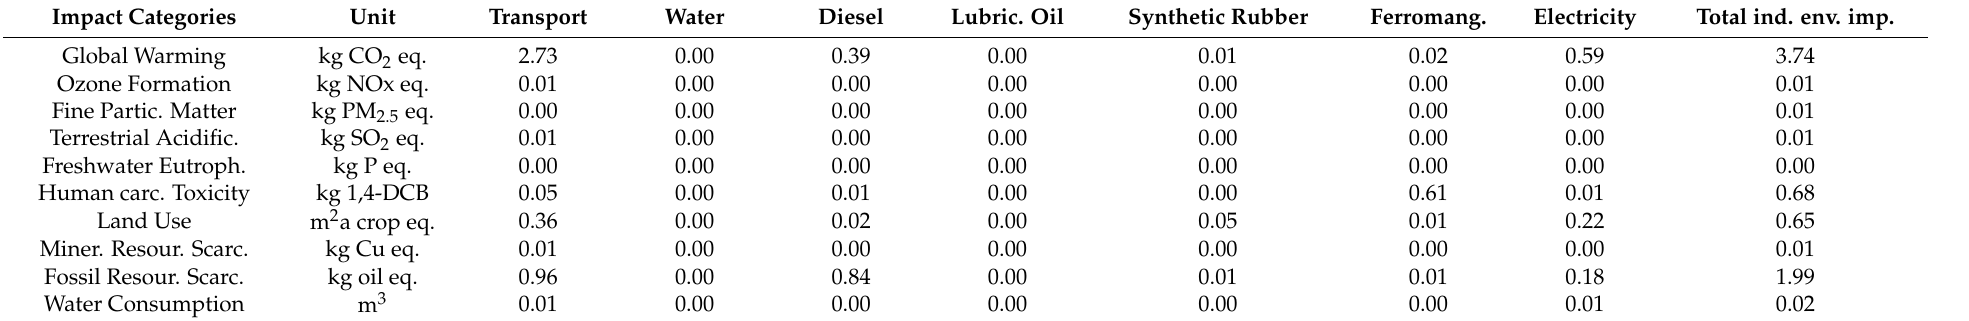
Table 5. LCA induced environmental characterized impacts associated to the collection and recycling of 1 tonne of C&DW.